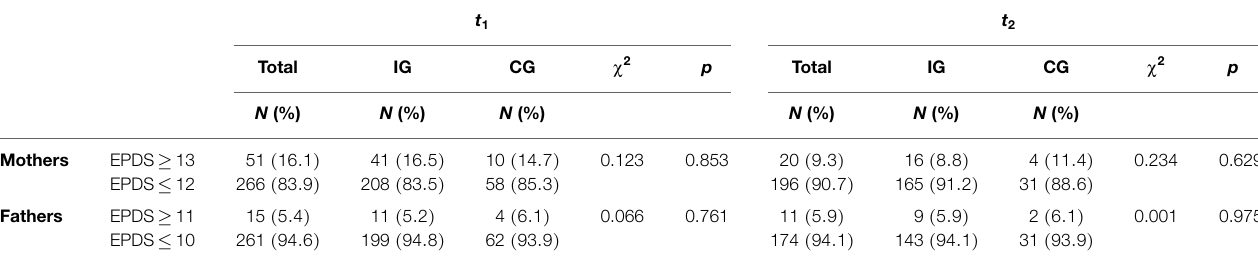
TABLE 3 | Number and proportion of mothers and fathers scoring above and below EPDS cut-offs at t 1 and t 2 and inferential statistics of between group comparisons .